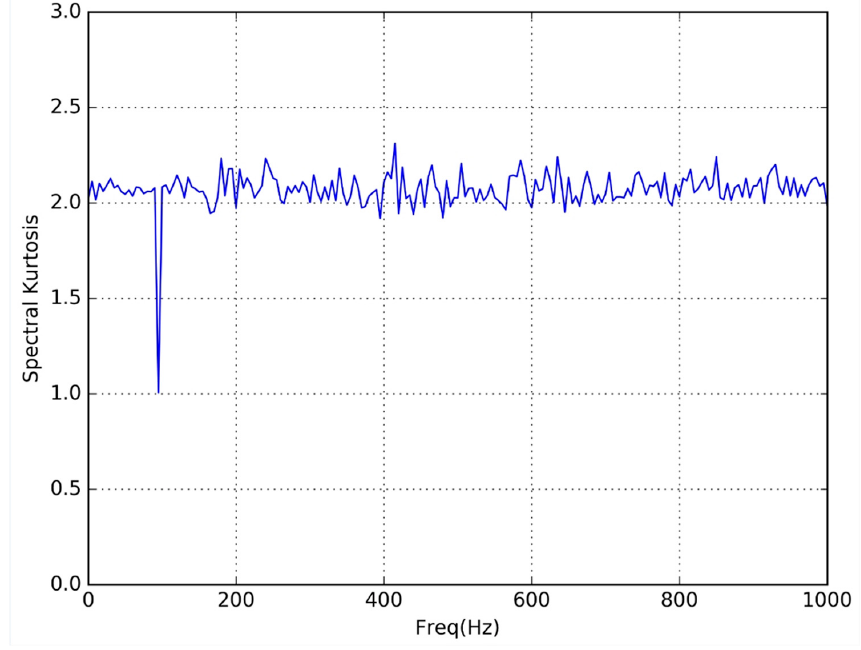
Figure 4. SK from experiment Processor 1. Sine wave signal, 100 Hz.